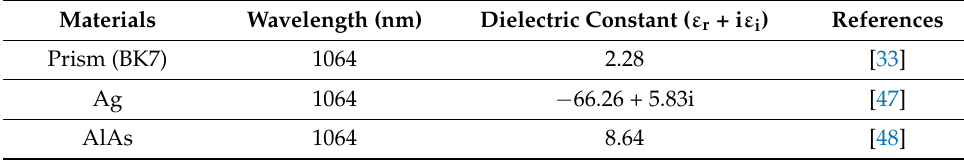
Table 1. Parameters of materials used for